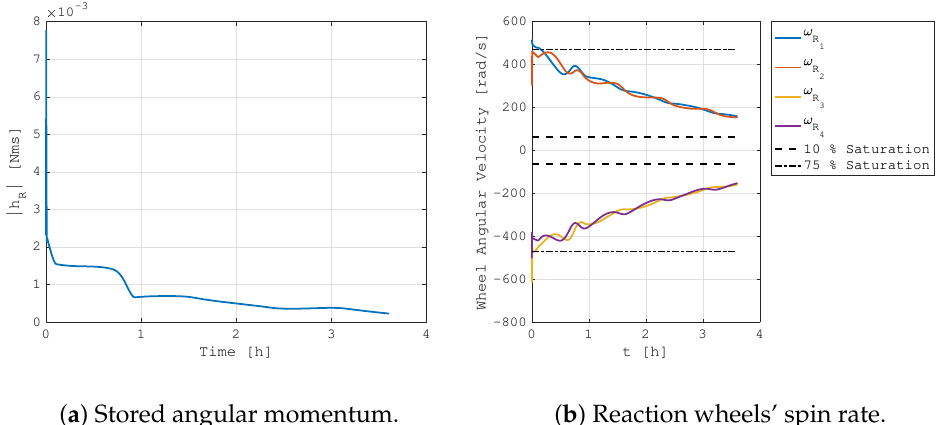
Figure 7. Stored angular momentum evolution in reference attitude tracking control.